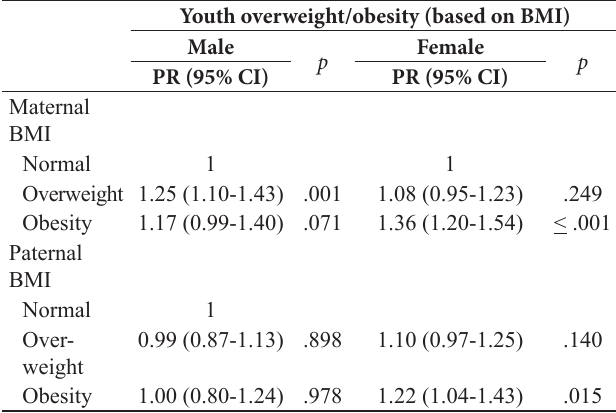
Table 5. Relationship between youth and parental overweight/obesity in 2008. Youth overweight/obesity (based on